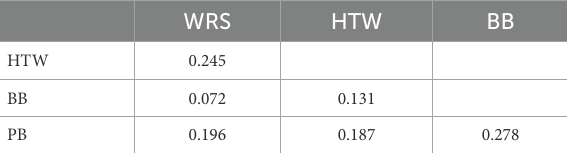
TABLE 8 Results from Spearman’s Rho bivariate correlation analysis for motor competence for males ( n = 43). WRS